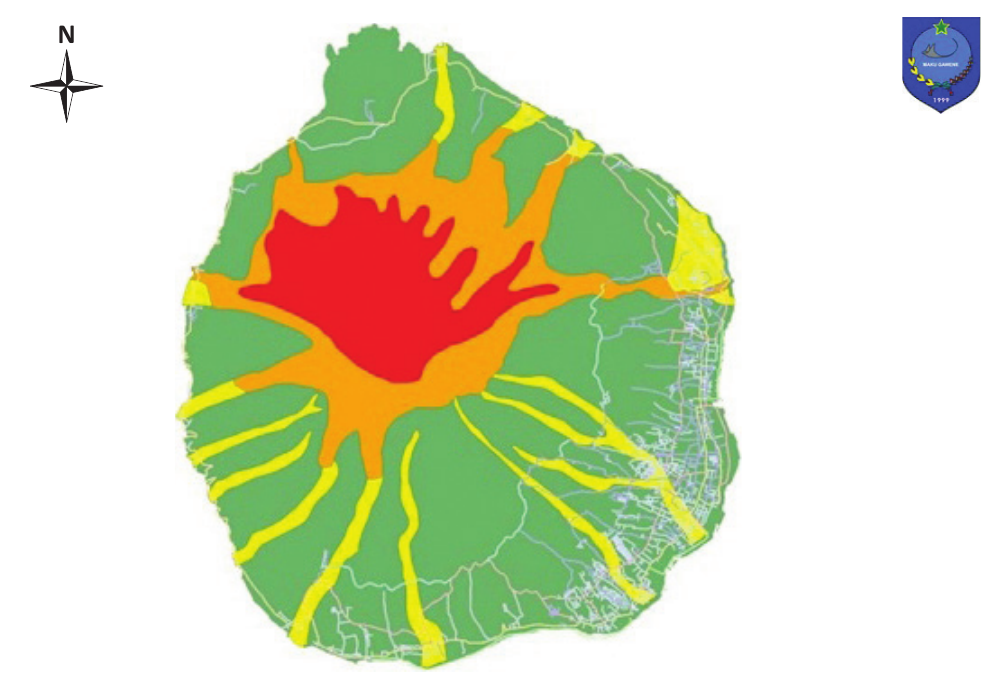
FIGURE 1 : Disaster-prone zone map in Mount Gamalama.